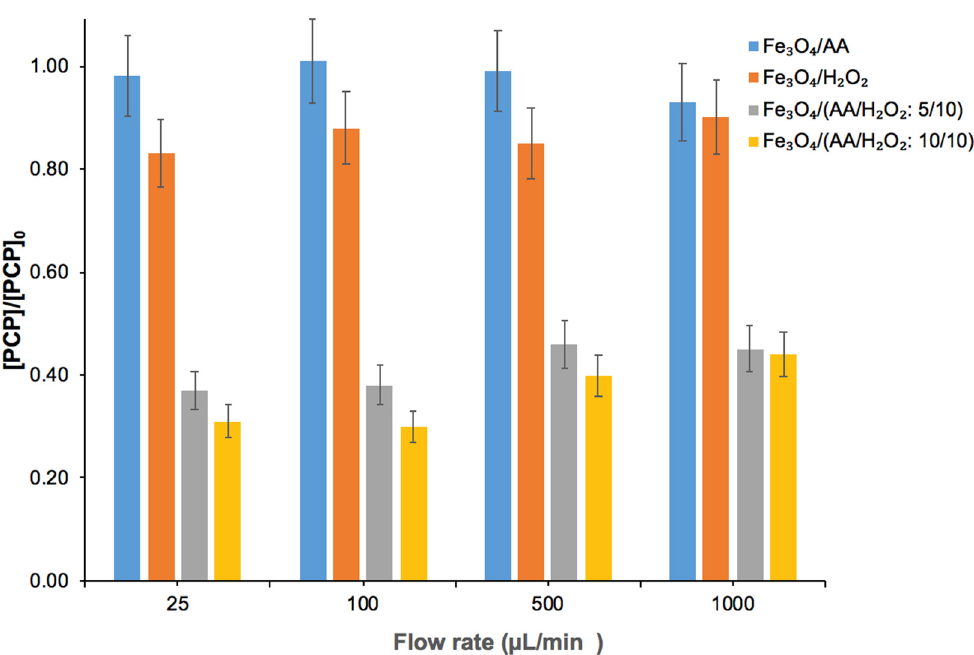
Figure 7. Degradation of PCP in saturated soil columns by using Fe 3 O 4 /AA, Fe 3 O 4 /H 2 O 2 , and Fe 3 O 4 /(AA/H 2 O 2 : 5/10 or 10/10 mM) at different flow rates (25, 100, 500, and 1000 µ L min − 1 ). For the first two treatments, 10 mM of both AA and H 2 O 2 were used. For all columns, 5 g of PCP-contaminated soil (initial pH 7.2) pre-mixed with magnetite (5 g kg – 1 soil w/w) was used. [PCP] represents the PCP concentration after oxidation and [PCP] 0 is its concentration at t = 0 (before treatment) determined by HPLC.